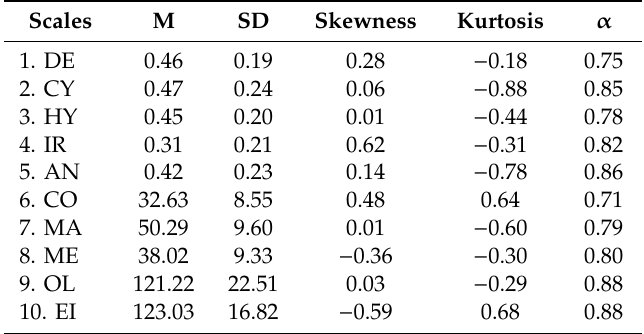
Table 1. Descriptive statistics for the Assessment of the Temperament Evaluation of Memphis, Pisa and San Diego Autoquestionnaire (TEMPS-A), Orientation to Life Questionnaire (OLQ), and Emotional Intelligence Questionnaire (INTE) ( n =